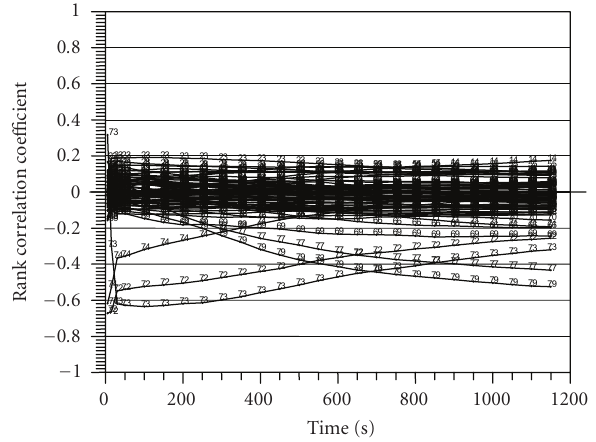
Figure 7: Sensitivity measures for pressure in the upper part of the containment versus